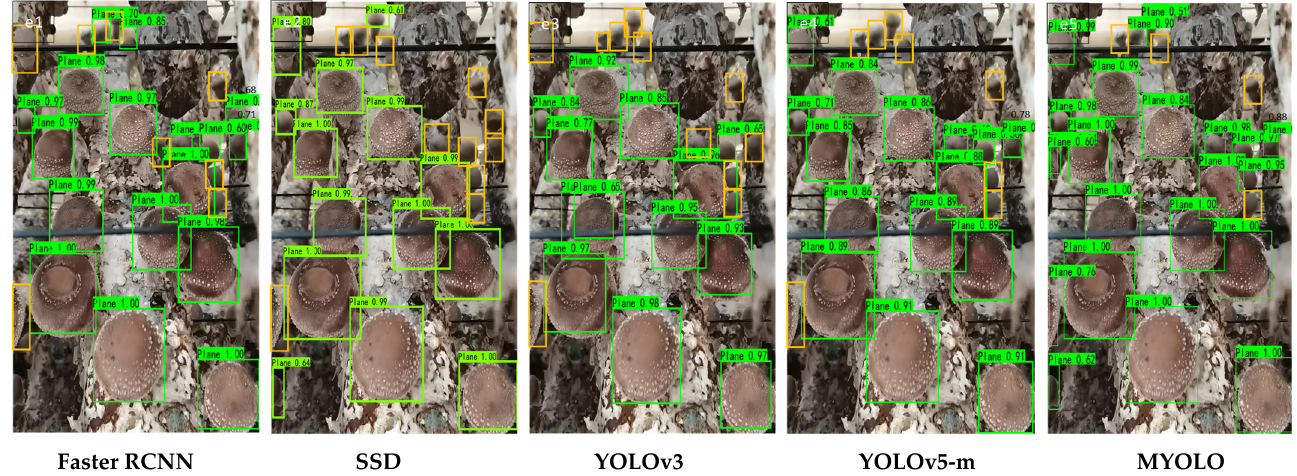
Figure 15. Detection results for each algorithm in different scenarios. (The yellow box is the target of the missed detection).